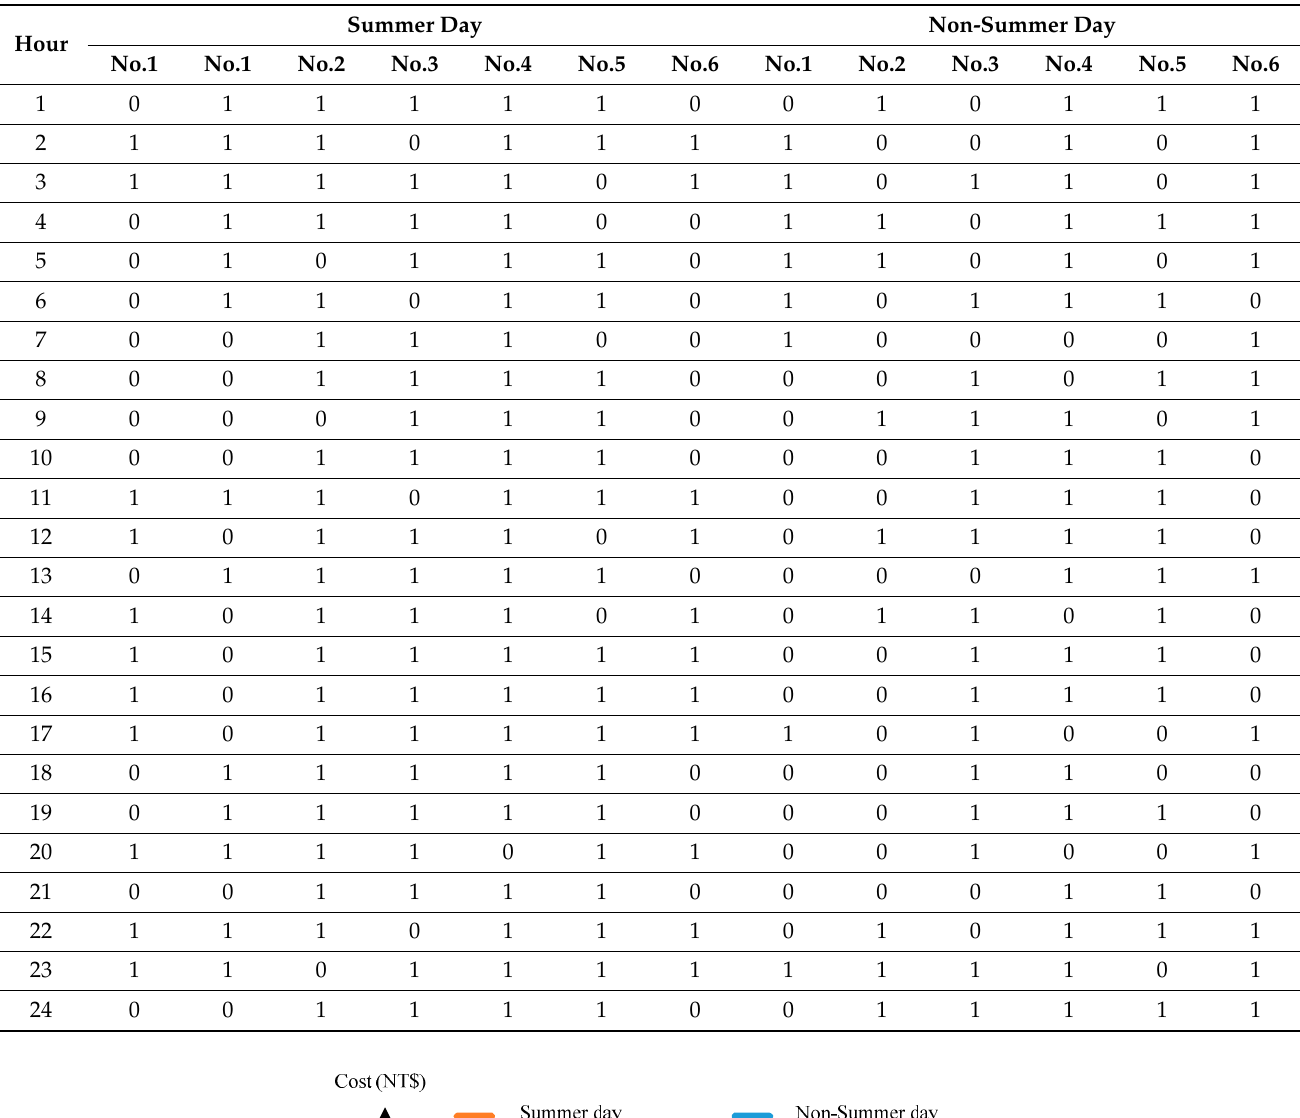
Table 5. The operating status of chillers on a summer day and non-summer day.